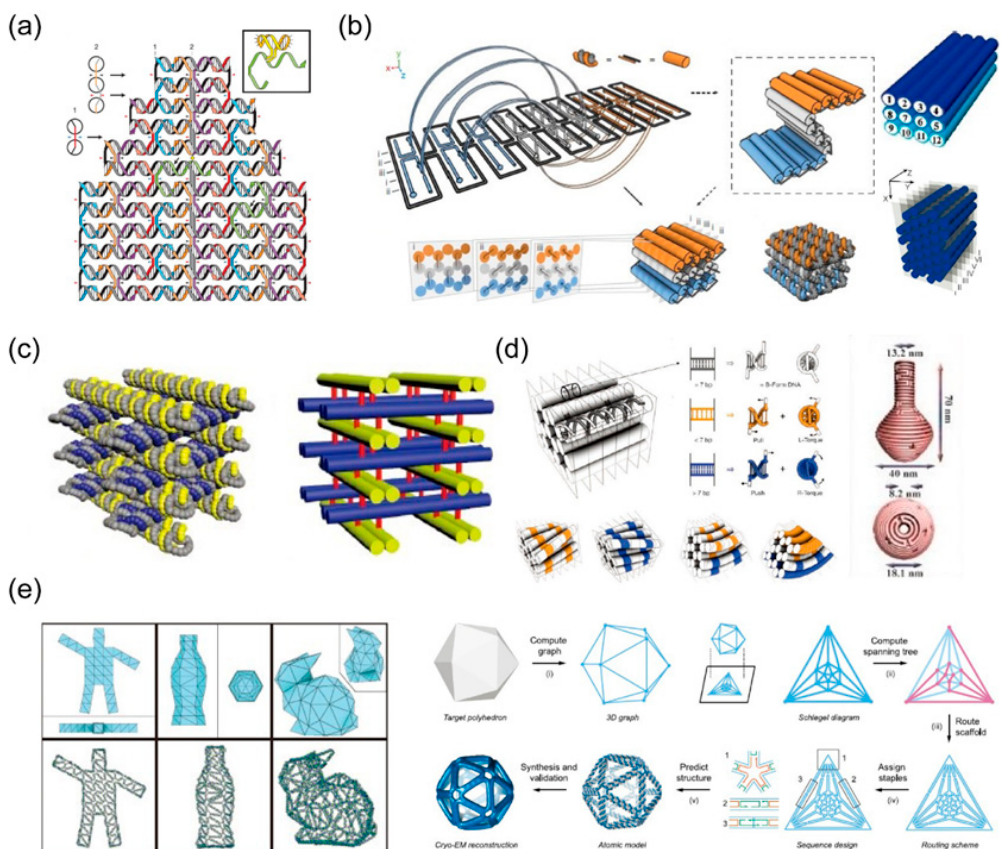
Figure 3. Development of DNA origami. ( a ) The origin of DNA origami: A long DNA strand is folded into a target structure through several short DNA strands. Reproduced with permission of [8].